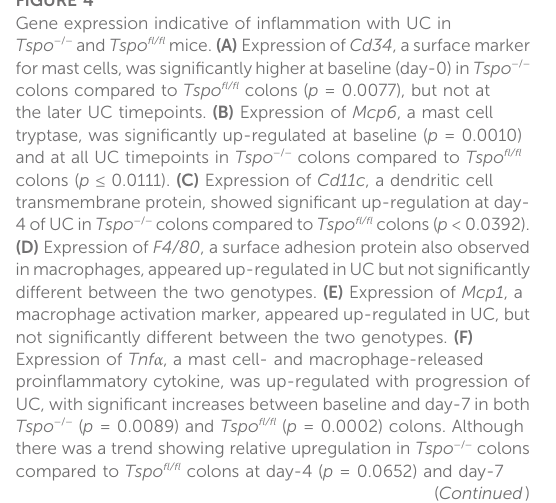
Gene expression indicative of in fl ammation with UC in Tspo − / − and Tspo fl / fl mice. (A) Expression of Cd34 , asurfacemarker colons compared to Tspo fl / fl colons ( p = 0.0077), but not at the later UC timepoints. (B) Expression of Mcp6 , a mast cell